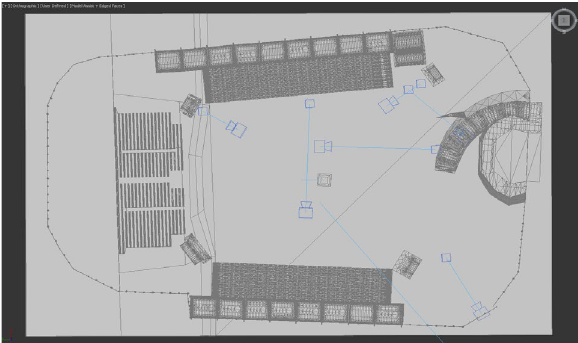
Figure 10 . Top view of 3ds Max environment showing cameras used for animations. ©